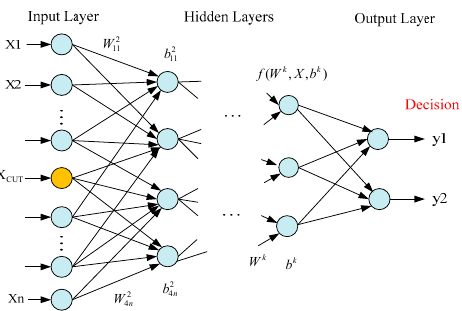
Figure 7. A typical architecture of a multi ‐ layer ANN detector .